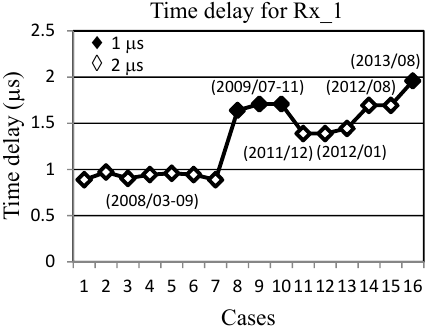
Figure 2. Time delays in different time periods. Refer to Table 1 for Figure 2: Time delays in different time periods. Refer to Table 1 for the observational the observational time period of each time period of each case.